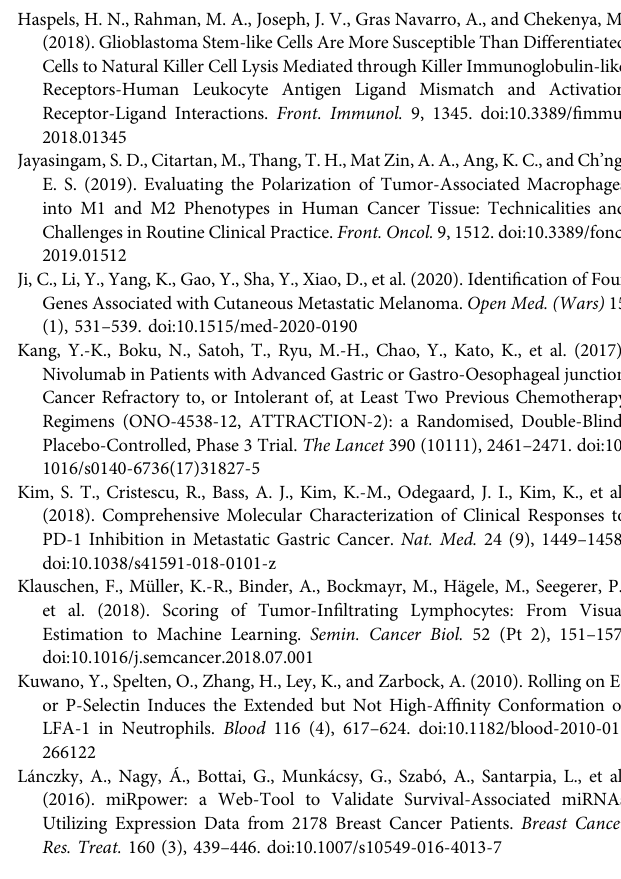
Supplementary Figure 1 | Correlation between ITGAL and PD1 expression based on immunohistochemical